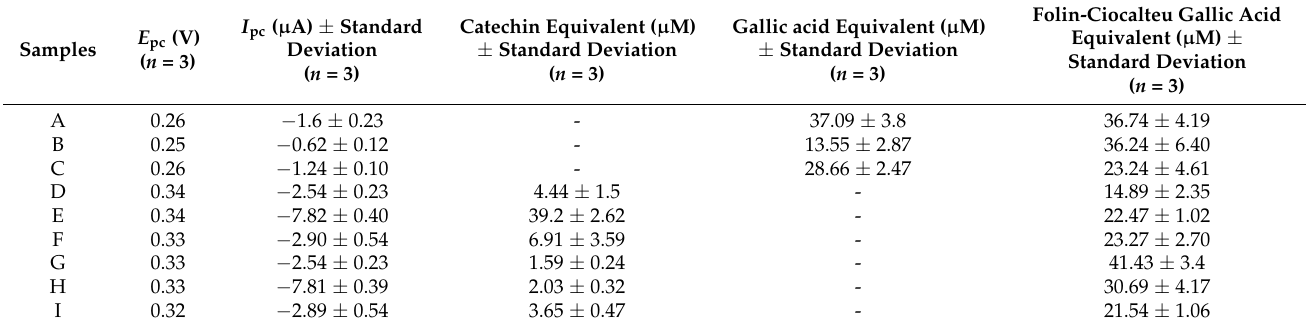
Table 4. Analysis of green tea samples with CP-50ME in 100 mM sodium acetate buffer pH 5.0 after 2 min and 30 s of enzymatic reaction.